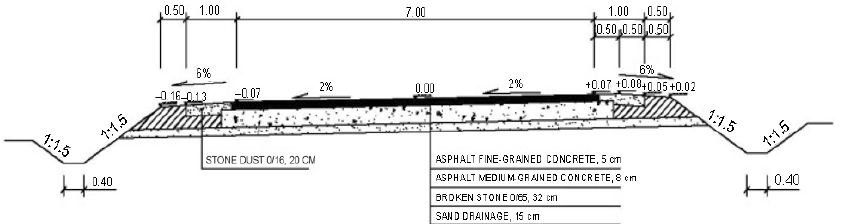
Fig. 4. The section of an access road to a dumping ground